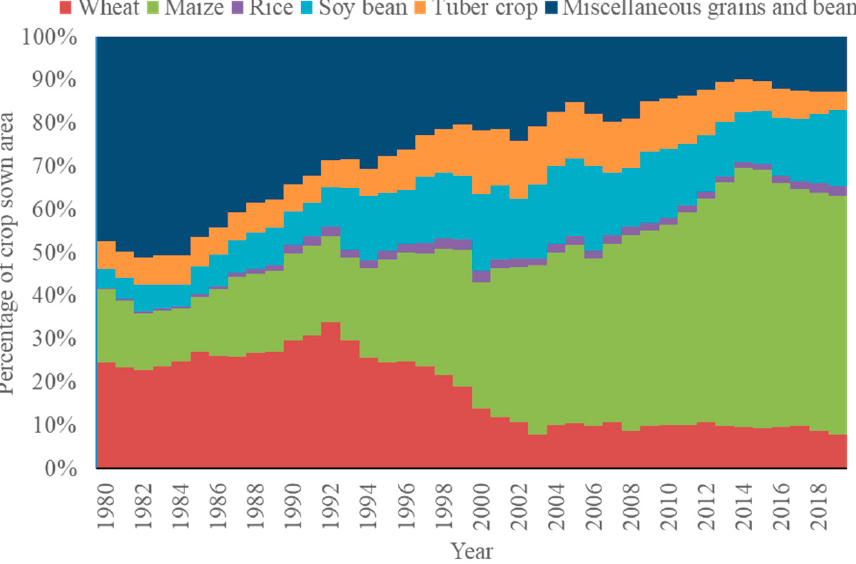
Figure 4. Grain plantation structure of Inner Mongolia Autonomous Region from 1980 to 2019.